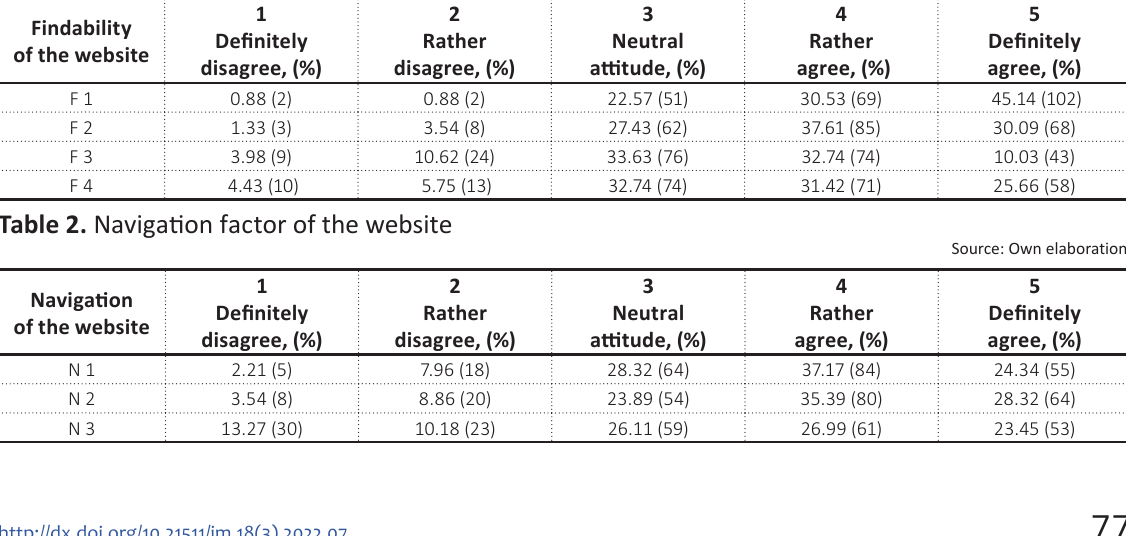
Table 1. Findability factor of the website